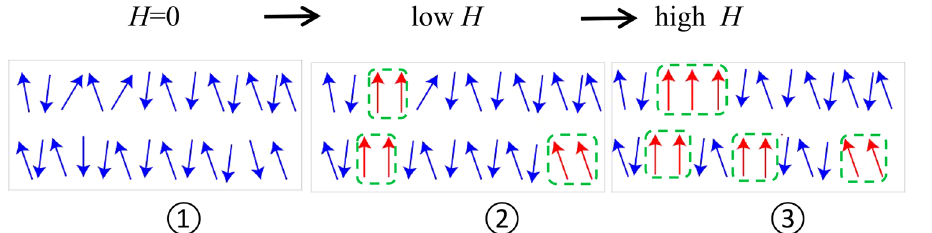
Figure 9. Schematic diagram of the AFM/FM structure for bulk BSCFO under different magnetic fields. The datasets generated and/or analyzed during the current study are available in the [CSD Crystallographic